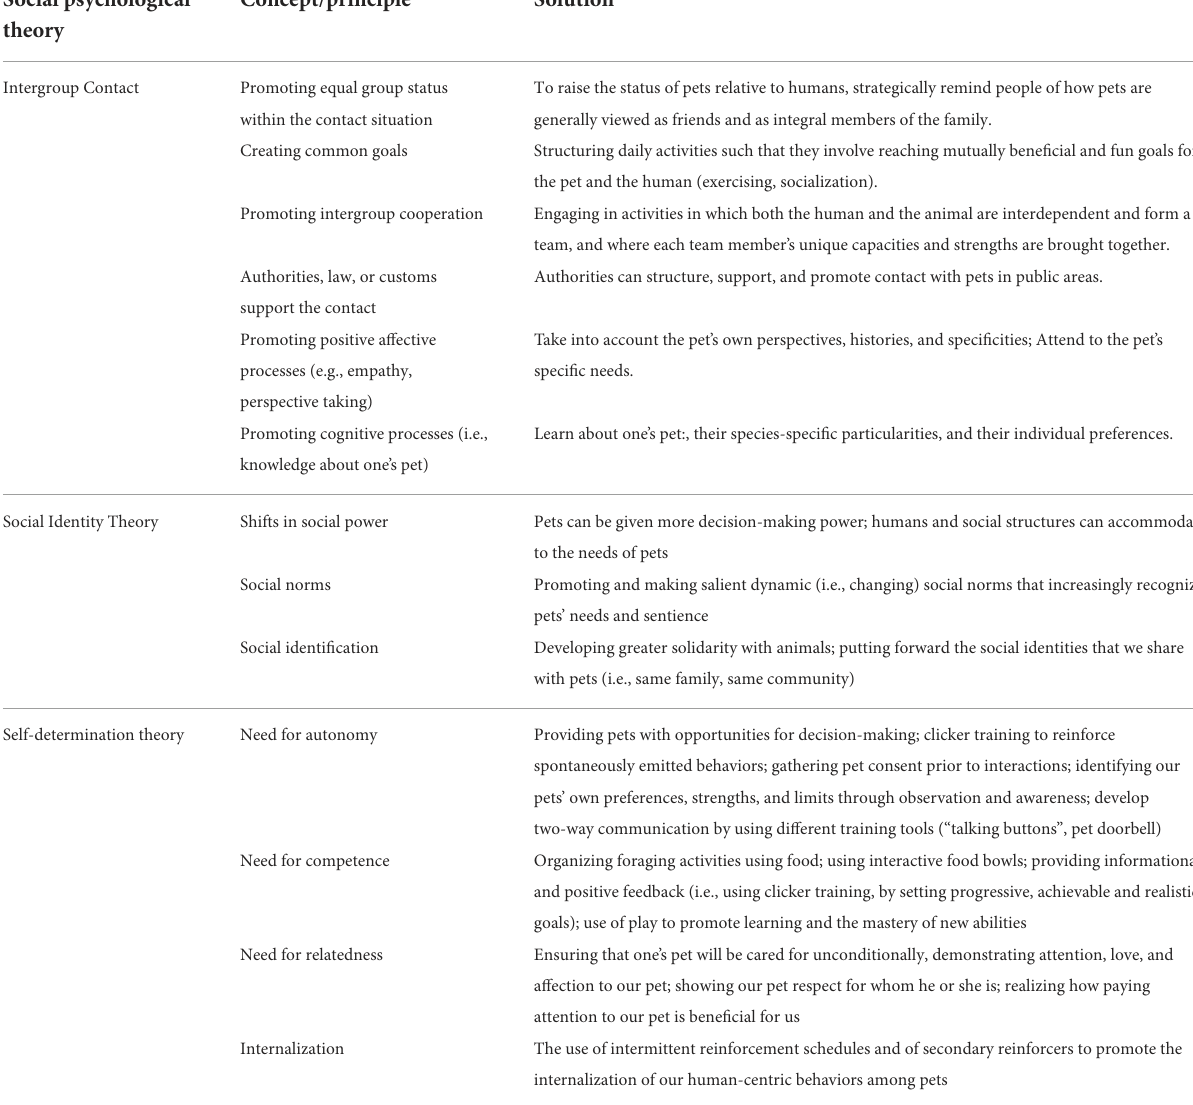
TABLE 1 Overview of the theoretically-based solutions proposed for achieving more equal and mutual human-pet